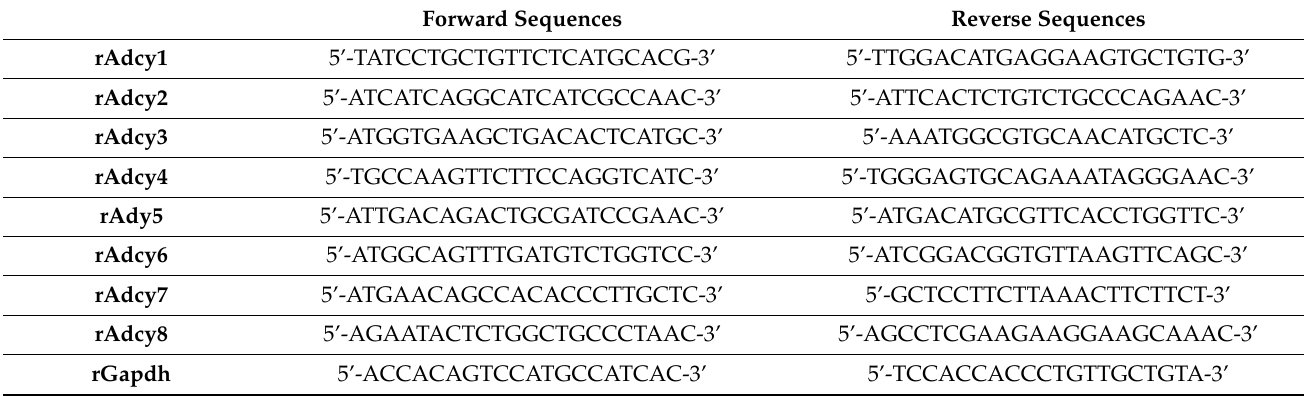
Table 1. List of PCR primers for rat AC1–8 and GAPDH. Specificities were checked in the database NCBI-BLAST (https://blast.ncbi.nlm.nih.gov/Blast.cgi (accessed on 1 January 2020), and accuracies were checked by the singular melting peaks using LightCycler. RT-PCR products on the Tris-borate- EDTA gel. The rat GAPDH primer is routinely used in our experiments [23]. Forward Sequences Reverse